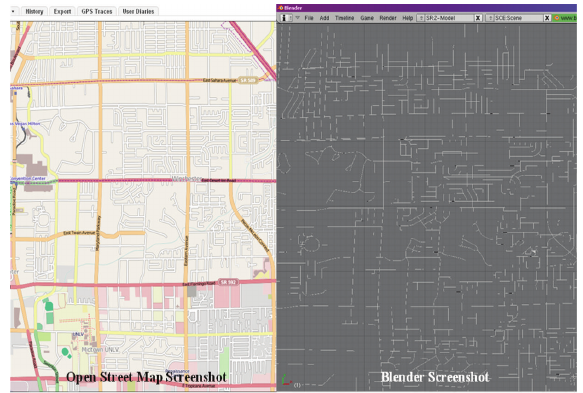
Figure 3: Generated network on Blender using Open Street